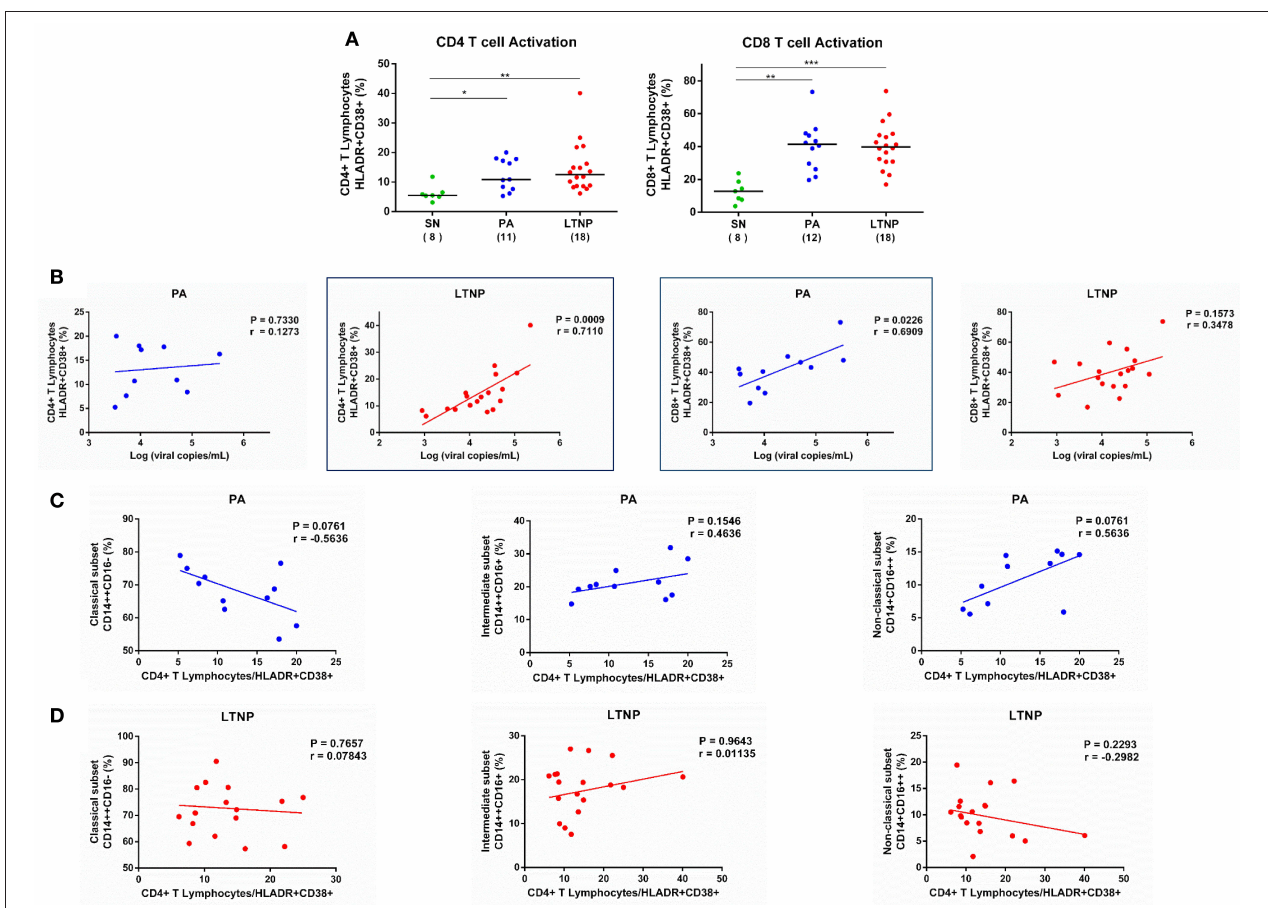
FIGURE 7 | Association of T cell activation with viremia and frequency of monocyte subsets in therapy-naïve cohorts. (A) Comparison of CD4 + and CD8 + T lymphocyte activation in therapy-naïve groups (PA and LTNP) with seronegative (SN) controls. Kruskal-Wallis ANOVA followed by Dunn’s multiple comparison test was applied to assess significance; * P < 0.05; ** P < 0.01; *** P < 0.001. (B) Association of T cell activation with viremia in PA and LTNP groups. (C,D) Association of CD4 + T lymphocyte activation with frequency of monocyte subsets in PA and LTNP groups, respectively. Association between variables was assessed using Spearman correlation analysis to determine correlation co-efficient “ r ” and test significance ( P <